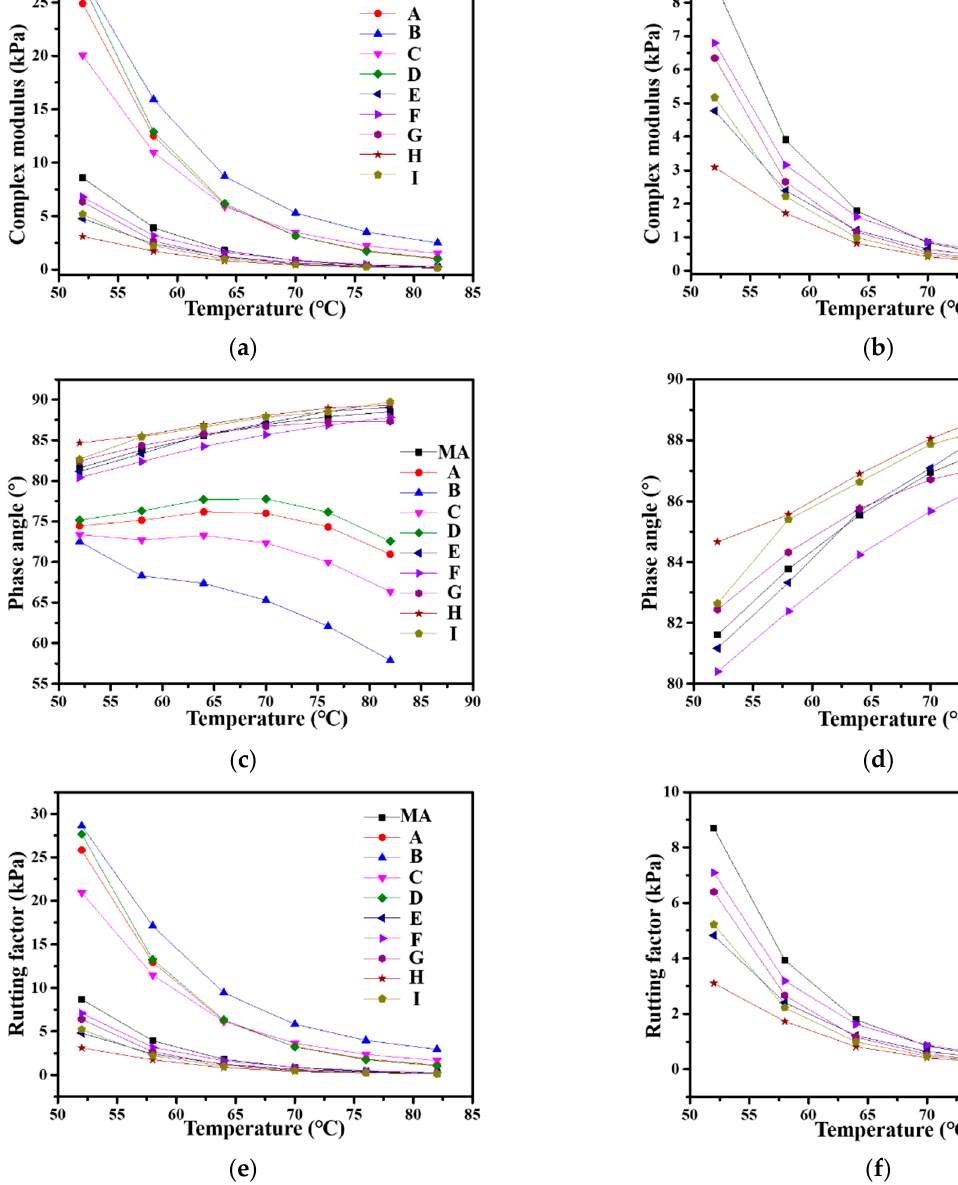
Figure 7. Rheological properties of MA and PPWA: ( a , b ) Complex modulus; ( c , d ) Phase angle; ( e , f ) Rutting factor.